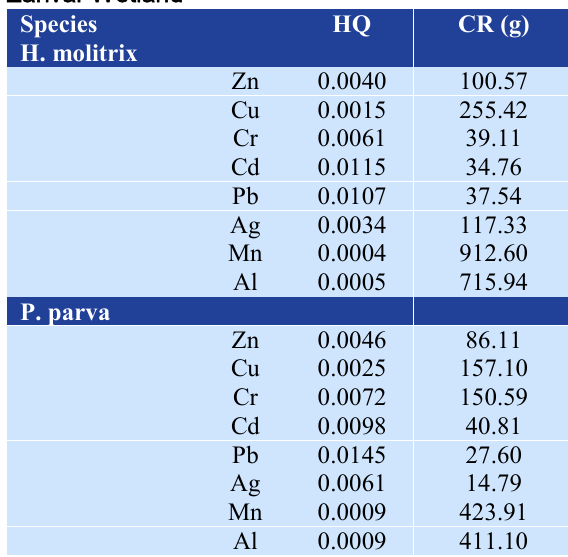
Table 4. HQ and CR indexes for two fish species in Zarivar